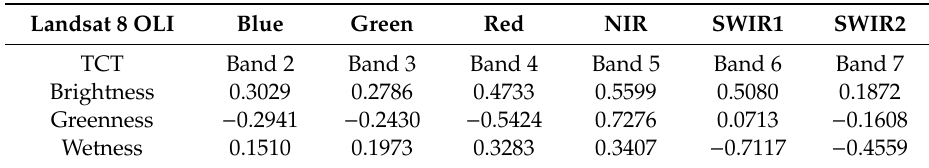
Table 3. Tasseled cap transformation (TCT) coe ffi cients for the Landsat 8 Operational Land Imagery (OLI) bands derived by Baig et al. [44]. Landsat 8 OLI Blue Green Red NIR SWIR1